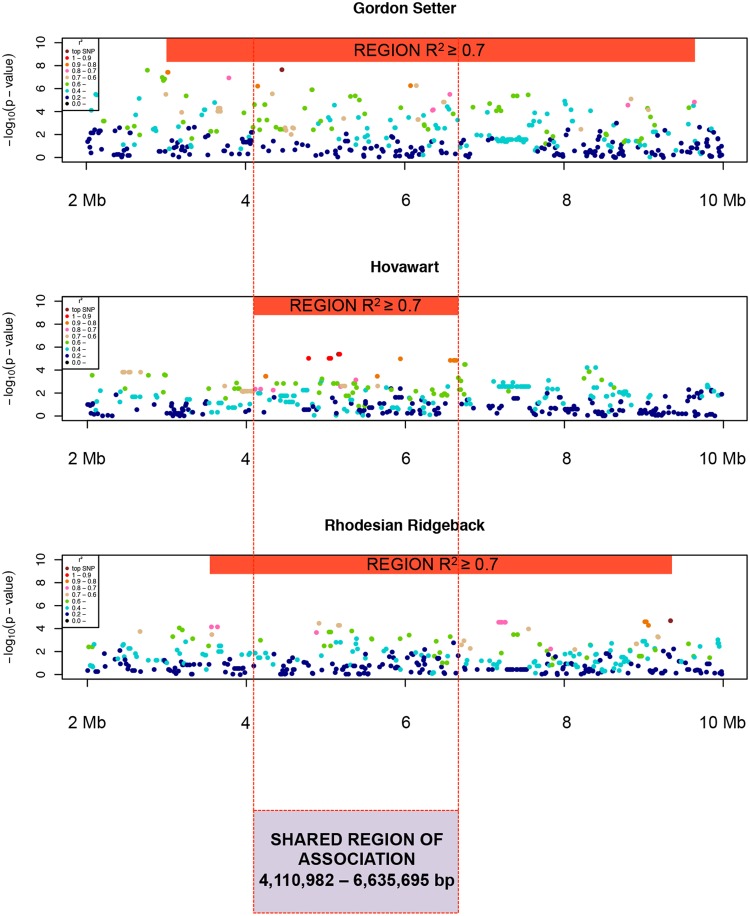
Breed-specific LD Manhattan plots of relevant region on CFA12, indicating R2-values of each SNP in respect to the highest associated markers.Orange bars are highlighting the associated regions (R2 ≥ 0.7) in GS (3,022,017–9,637,877 bp), HV (4,110,982–6,635,695 bp) and RR (3,561,421–9,336,752 bp). Dashed lines indicate the shared region of association (4,110,982–6,635,695 bp).